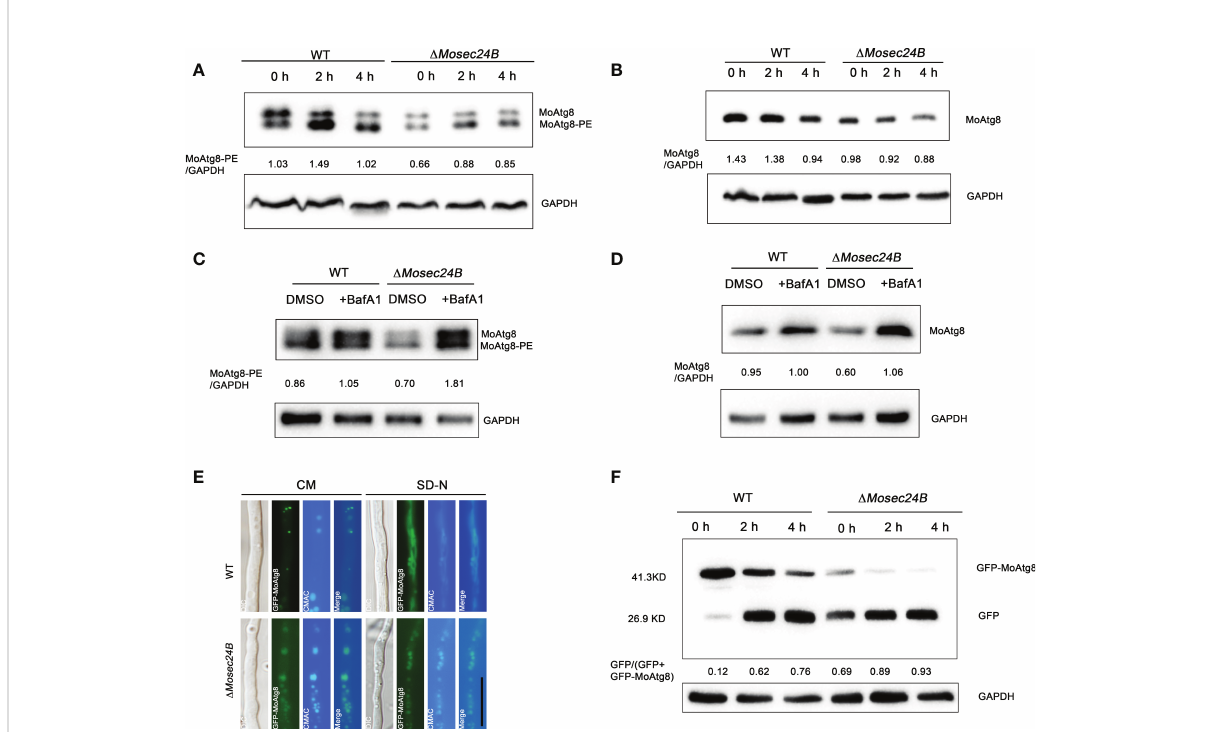
FIGURE 9 MoSec24B is engaged in the process of autophagy. (A) Analysis of MoAtg8 lipidation to form MoAtg8-PE in WT and D Mosec24B . To assess the conversion rate of MoAtg8 lipidation to form MoAtg8-PE, the ratio of total MoAtg8-PE to total GAPDH was calculated. (B) Analysis of MoAtg8 protein detection in WT and D Mosec24B . To assess the content of MoAtg8, the ratio of MoAtg8 to total GAPDH was calculated. (C) Analysis of MoAtg8 lipidation to form MoAtg8-PE in WT and D Mosec24B after BafA1 treatment for 4 h. (D) Analysis of MoAtg8 protein detection in WT and D Mosec24B after BafA1 treatment for 4 h. (E) Subcellular localization of GFP-MoAtg8 in WT and D Mosec24B under fl uorescence microscopy. Scale Bar = 10 m m. Mycelia were stained with CMAC, which is used to stain vacuoles. (F) Autophagy fl ux analysis of GFP-MoAtg8 in WT and D Mosec24B . Total GFP-MoAtg8 and free GFP protein were detected by western blotting. The proportion of the amount of free GFP to the total amount of intact GFP-MoAtg8 and free GFP was calculated for the purpose of assessing the extent of autophagy. The protein content of GAPDH as a control. ImageJ software was used to analyze the grayscale value of each independent